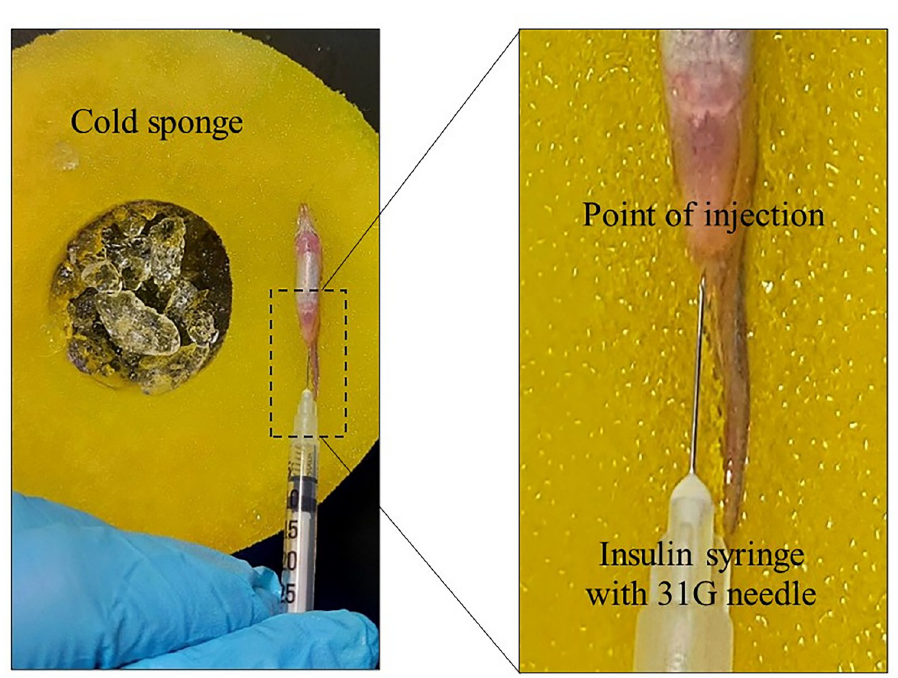
Fig 2. Representative diagram of the experimental setup for intraperitoneal injection. Anesthetized zebrafish was placed ventral side up on a cold sponge. The zoomed-in section depicts the point where the injection was given. A 31G needle attached to an insulin syringe was inserted into the injection point to deliver the MPTP (for MPTP-injected group) or saline solution (for control